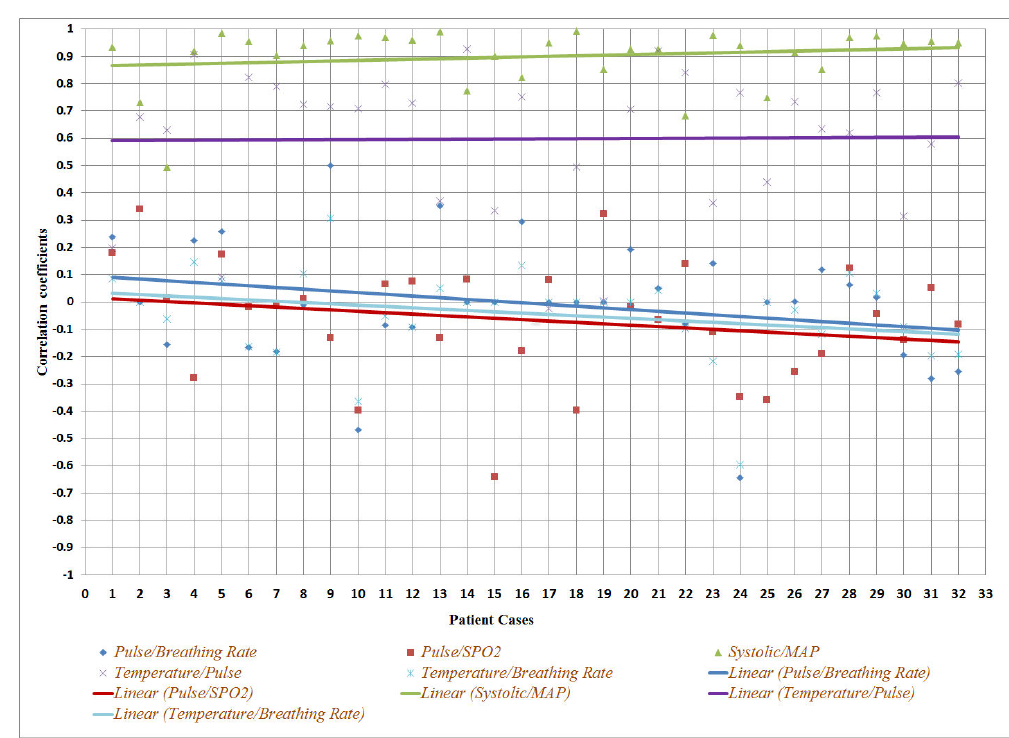
Figure 5. Linearity of Correlation